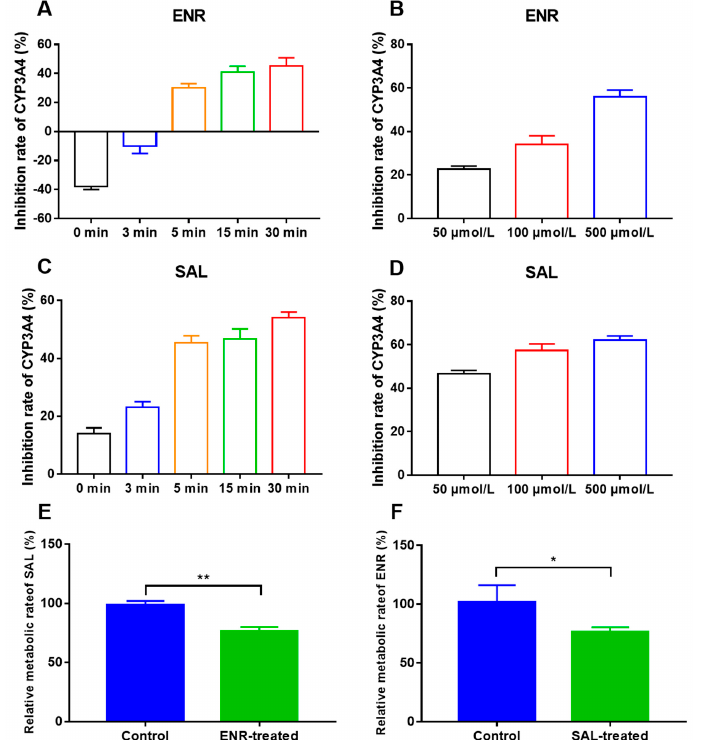
Figure 2. The effects of different pre-incubation times and drug concentrations on the metabolic activity of CYP3A4. ( A , B ) are the inhibition rates of CYP450 enzyme activity with different concentrations of ENR and 100 μ mol/L ENR pre-incubated for 0, 3, 5, 15, and 30 min, respectively. ( C , D ) are the inhibition rates of CYP450 enzyme activity with different concentrations of SAL and 100 μ mol/L ENR pre-incubated for different times, respectively. ( E ) is the relative metabolism rate of SAL in the presence of ENR; ( F ) is the relative metabolism rate of ENR in the presence of SAL. * means p < 0.05; ** means p < 0.01.